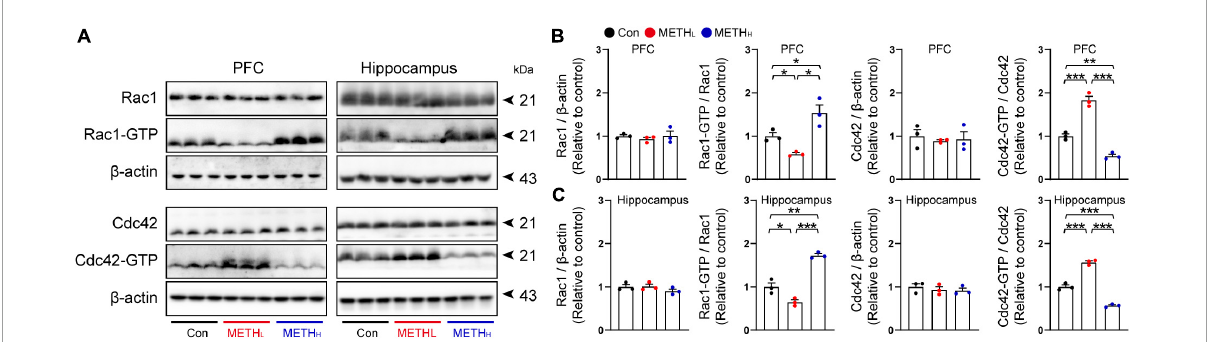
FIGURE6 Methamphetamine (METH) regulated Rac1 and Cdc42 activity in hippocampus and cortex. (A) Representative immunoblots of Rac1, Rac1-GTP, Cdc42, Cdc42-GTP and β -actin in PFC and hippocampus. (B) Quantification of Rac1 and Cdc42 normalized to β -actin, Rac1-GTP normalized to Rac1, and Cdc42-GTP normalized to Cdc42 in PFC. One-way ANOVA, Rac1/ β -actin, F (2, 8) = 0.393, p = 0.691, Rac1-GTP/Rac1, F (2, 26) = 15.933, p = 0.004, Cdc42/ β -actin, F (2, 8) = 0.178, p = 0.841, Cdc42-GTP/Cdc42, F (2, 8) = 0.178, p < 0.001. (C) Quantification of Rac1 and Cdc42 normalized to β -actin, Rac1-GTP normalized to Rac1, and Cdc42-GTP normalized to Cdc42 in hippocampus. One-way ANOVA, Rac1/ β -actin, F (2, 8) = 1.439, p = 0.309, Rac1-GTP/Rac1, F (2, 8) = 68.719, p < 0.001, Cdc42/ β -actin, F (2, 8) = 0.451, p = 0.657, Cdc42-GTP/Cdc42, F (2, 8) = 209.847, p < 0.001. n = 3. * p < 0.05, ** p < 0.01, *** p < 0.001 by one-way ANOVA and Bonferroni’s post hoc analysis.